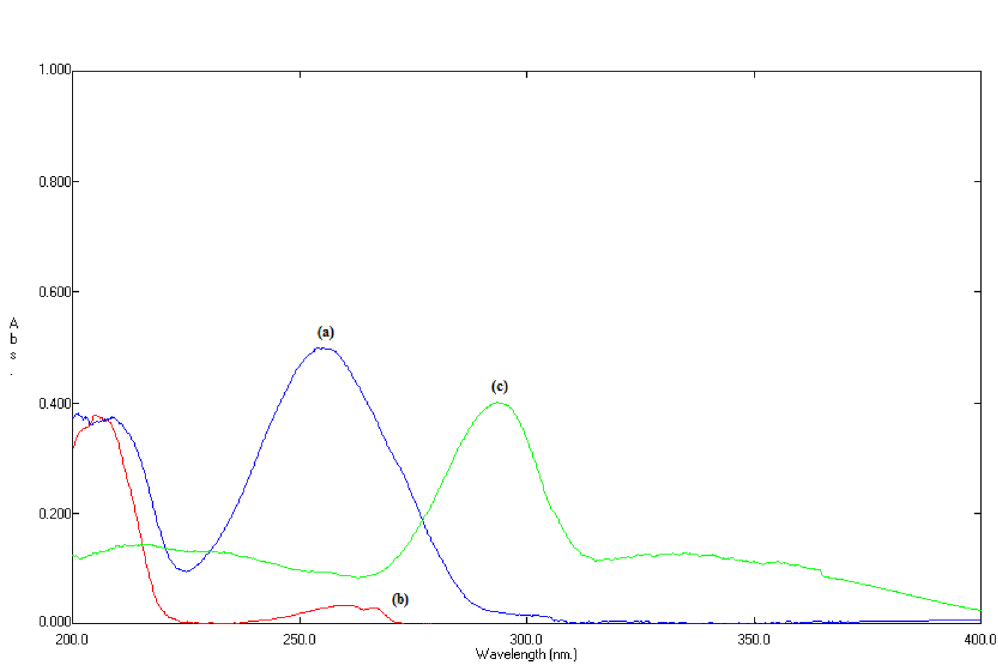
Figure 3. UV spectrum of: ( a ) PRN (5.0 μg/mL), ( b ) FLZ (20.0 μg/mL) and ( c ) MOX (5.0